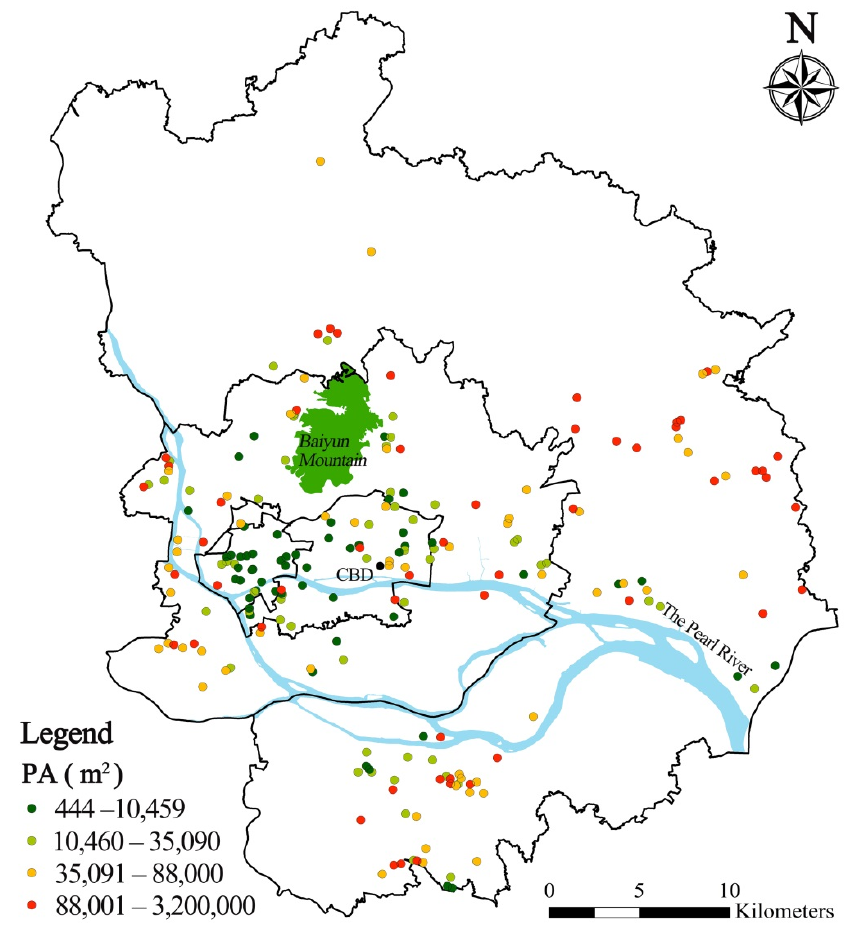
Figure 5. Spatial pattern of PA in residential quarters.